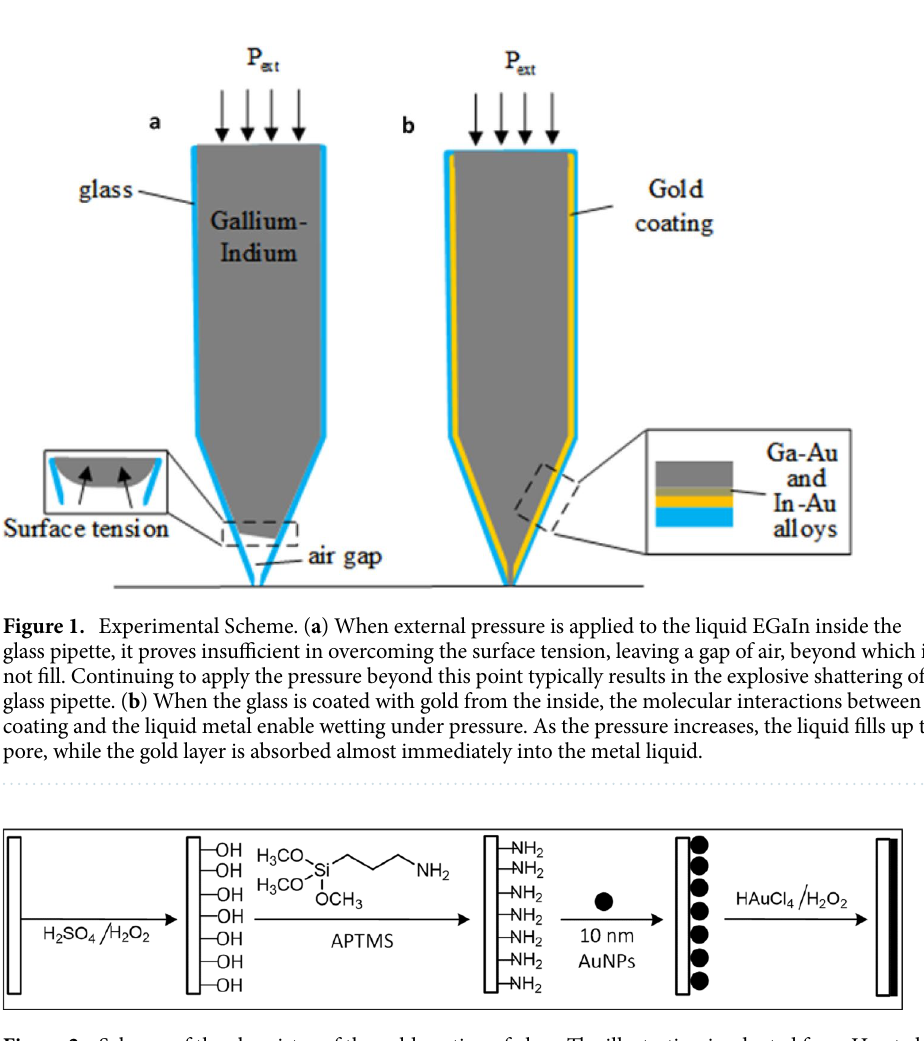
Figure 2. Scheme of the chemistry of the gold coating of glass. The illustration is adapted from Hu et al. 23 Left to right: after cleaning and surface activation, the inner surface of the glass tubes was functionalized with a solution of APTMS overnight by pumping the solution directly through the tubes. After thoroughly cleaning the tubes from the inside, they were seeded with 10 nm GNPs for 3–4 h, and electroless deposition was activated by introducing a solution of Gold (III) chloride trihydrate and H 2 O 2 as a reducing agent. The